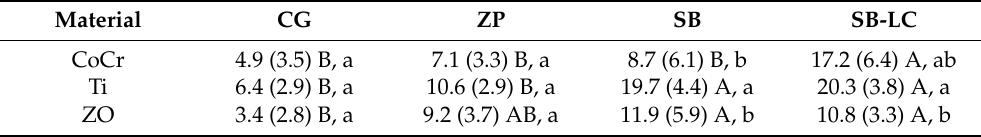
Table A3. Mean shear bond strength (MPa) and standard deviations for comparisons among groups.